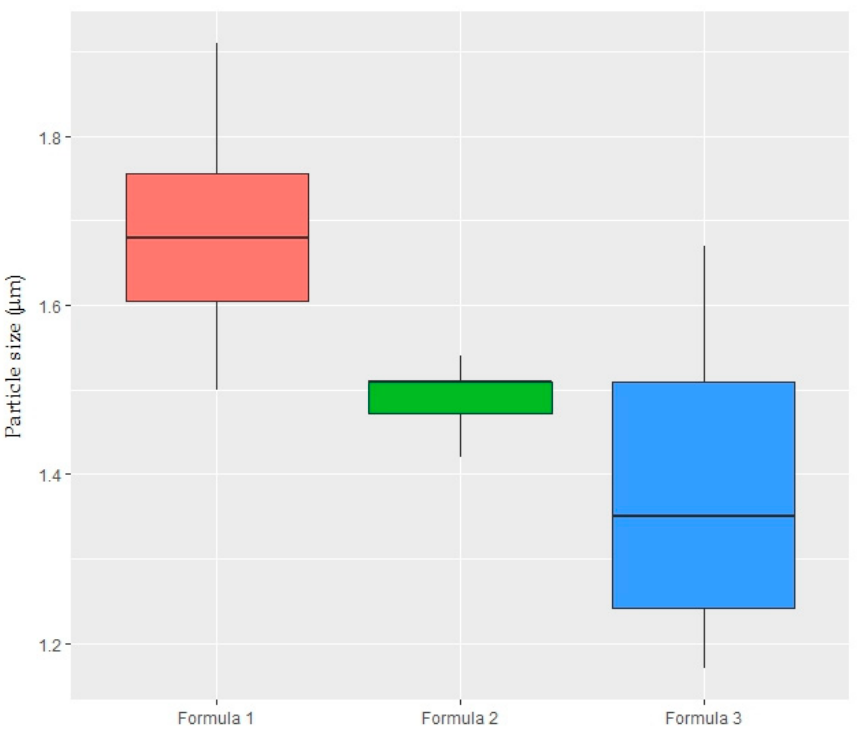
Figure 7. Box plot shows the emulsion droplet size (µm) as surface mean area diameter of the formulations. Formula 1: 1.25% sodium alginate + 2% glycerol + 0.2% sunflower oil + 1% span 80; Formula 2: 1.25% sodium alginate + 2% glycerol + 0.2% sunflower oil + 1% span 80 + 0.2% tween 40; Formula 3: 1.25% sodium alginate + 2% glycerol + 0.2% sunflower oil + 1% span 80 + 0.2% tween 80